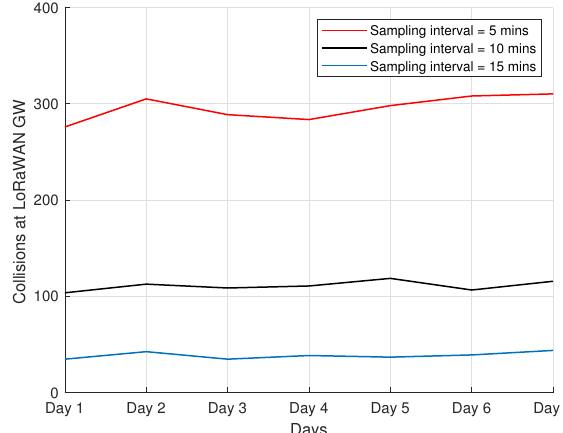
Figure 13. Collisions perceived by LoRa